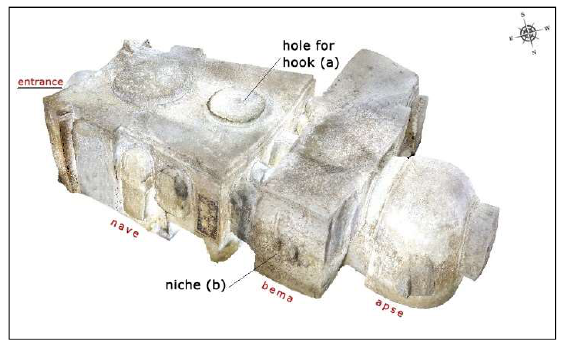
Figure 3: Agisoft Photoscan Sw. Texturing model.